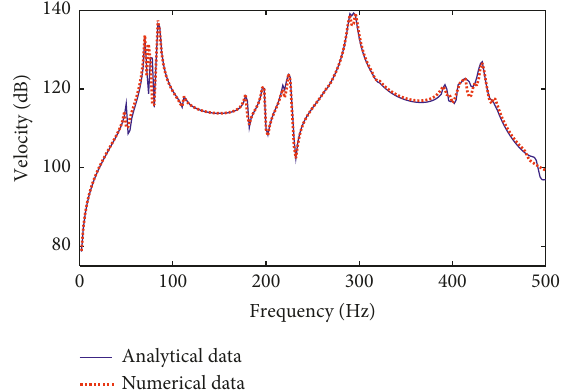
Figure 6: Vibration velocity response at the position ( x y � 0.1m) on the surface of panel 1. 1